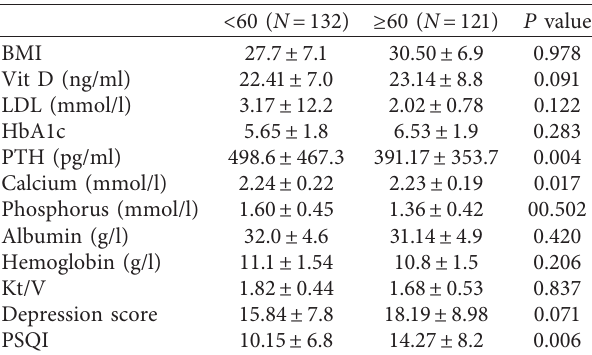
Table 4: Comparison between patients < 60 and patients ≥ 60 years based on different